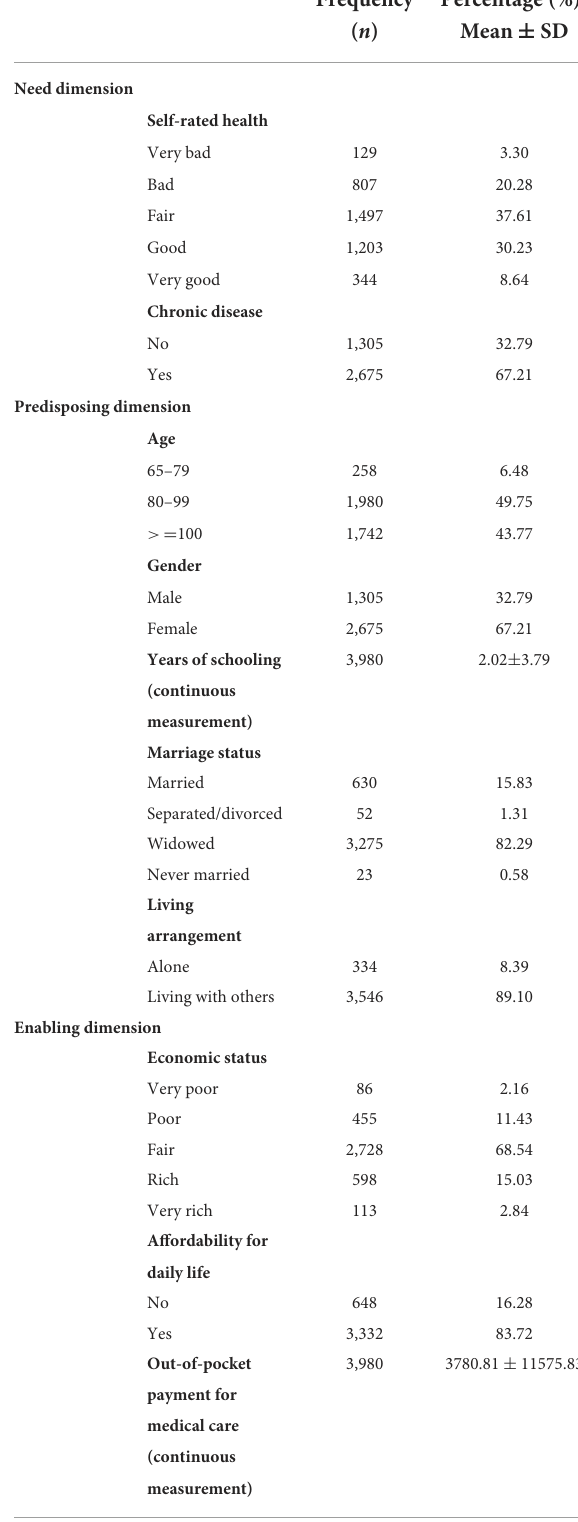
TABLE 1 Characteristics of participants after multiple amputation ( N =